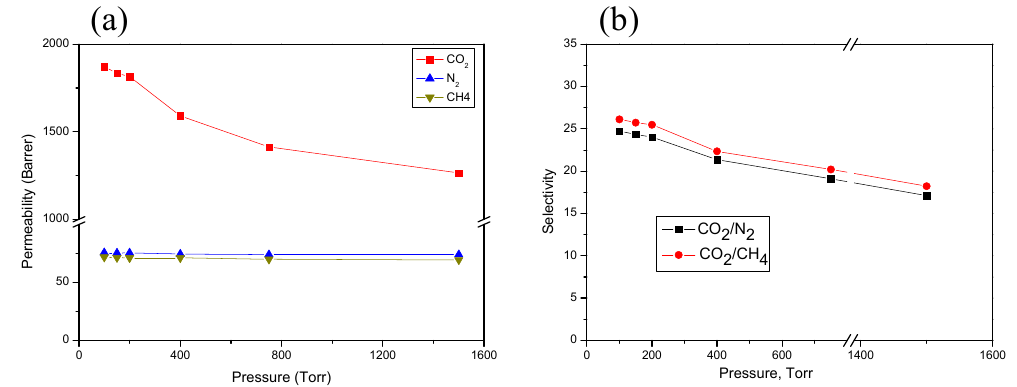
Figure 9. Gas permeability ( a ) and selectivity ( b ) of the (PIM-PI)-(6FDA-durene-PI)(1:4) membrane at various pressure ranges. the gas separation properties strongly indicate that the newly developed [(PIM-PI)x-(6FDA-durene-PI)y] random-type copolymers are promising candidate materials to be used for CO 2 separation, in particular at, but not only limited to, low pressures.